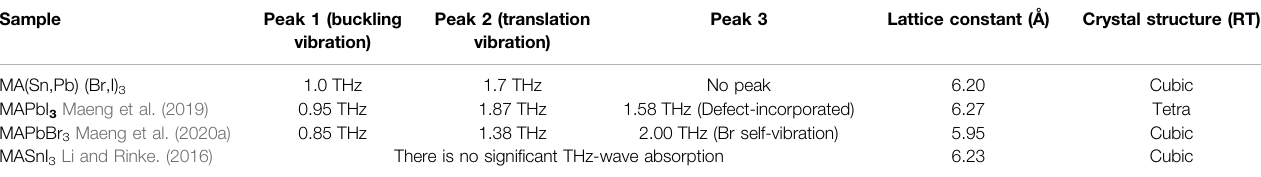
TABLE 1 | Comparison of THz-wave absorption properties of each perovskite thin fi lm.